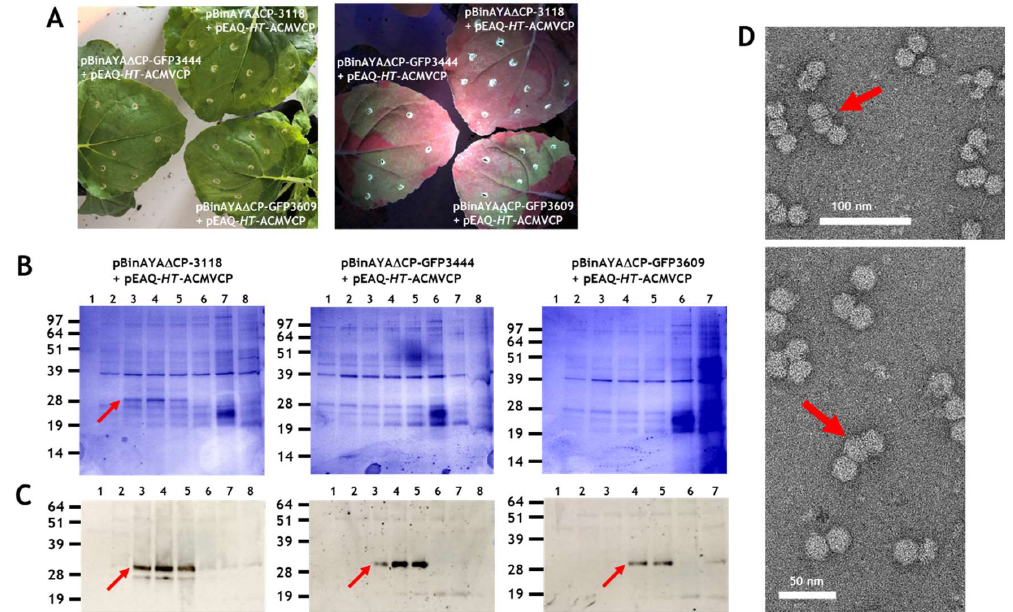
Figure 5. ( A ), GFP expression at 6 days post infiltration on leaves co-infiltrated with pEAQ-HT-ACMVCP and either pBinAYA ∆ CP-3118, or pBinAYA ∆ CP-GFP3444 or pBinAYA ∆ CP-GFP3609. Left panel photographed under natural light and right panel under UV light. ( B ), Instant Blue staining of 12% MOPS buffered NuPAGE gel of the caesium sulphate gradient profile of protein extracted from plants co-infiltrated with pEAQ- HT -ACMVCP and pBinAYA ∆ CP-3118 or with pBinAYA ∆ CP-GFP3444, or with pBinAYA ∆ CP-GFP3609 as indicated. Red arrow indicates ACMV coat protein. ( C ), ACMV coat protein (red arrow) detected by Western blotting with anti-ACMV antibody of samples resolved as in part ( B ). ( D ), Transmission electron microscopy of virus particles present in the peak fraction of the co-infiltration of pEAQ- HT -ACMVCP and pBinAYA ∆ CP3118. Red arrows indicate triple capsid structures. Bar size as indicated, 50 or 100